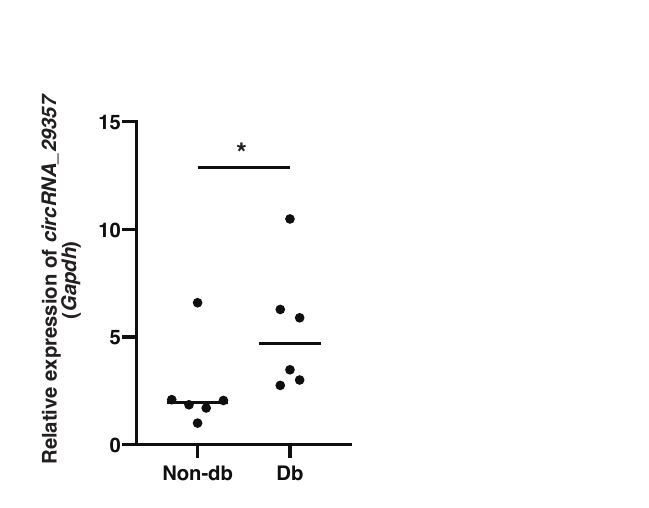
Figure 2. Identification of circRNAs with putative miR-129-2-3p binding sites. ( A ). The top seven circRNAs with putative miR-129-2-3p binding sites using Miranda and TargetScan from 206 circRNAs were extracted. The binding sequences between miR-129-2-3p and circRNAs are shown. ( B ). Relative expression of circRNA_29357 in Db. Graphs show mean ± SD ( n = 6). The statistical significance of differences between means was assessed by Mann–Whitney U test. * p < 0.05.